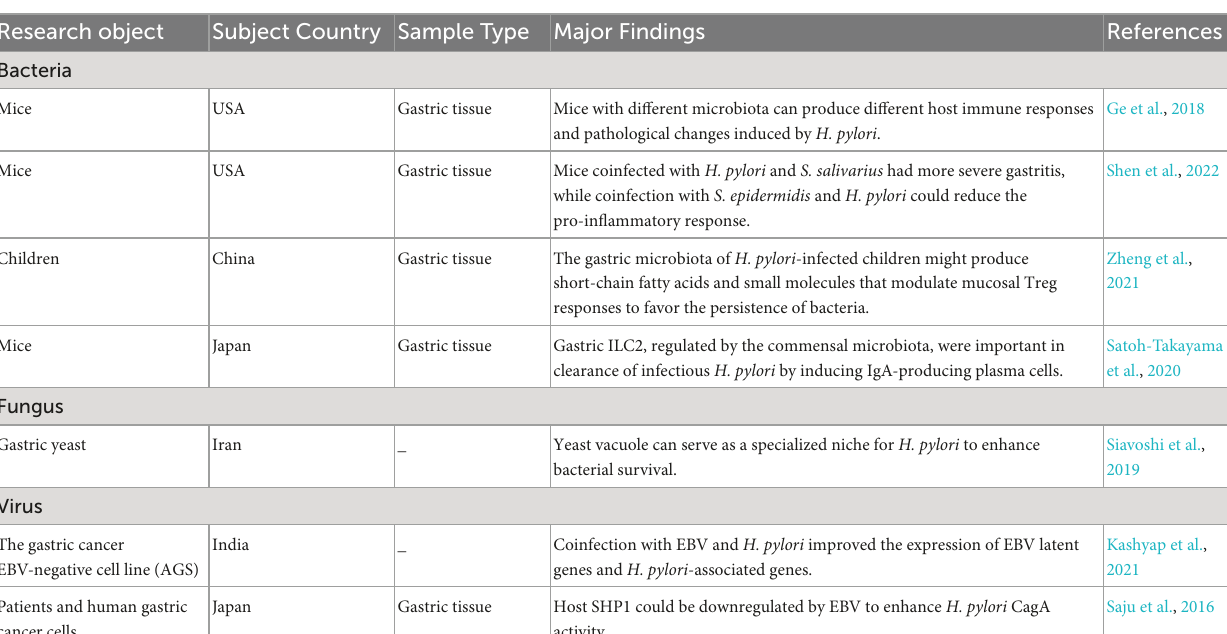
TABLE 1 The gastric microecology affects the host response to H. pylori